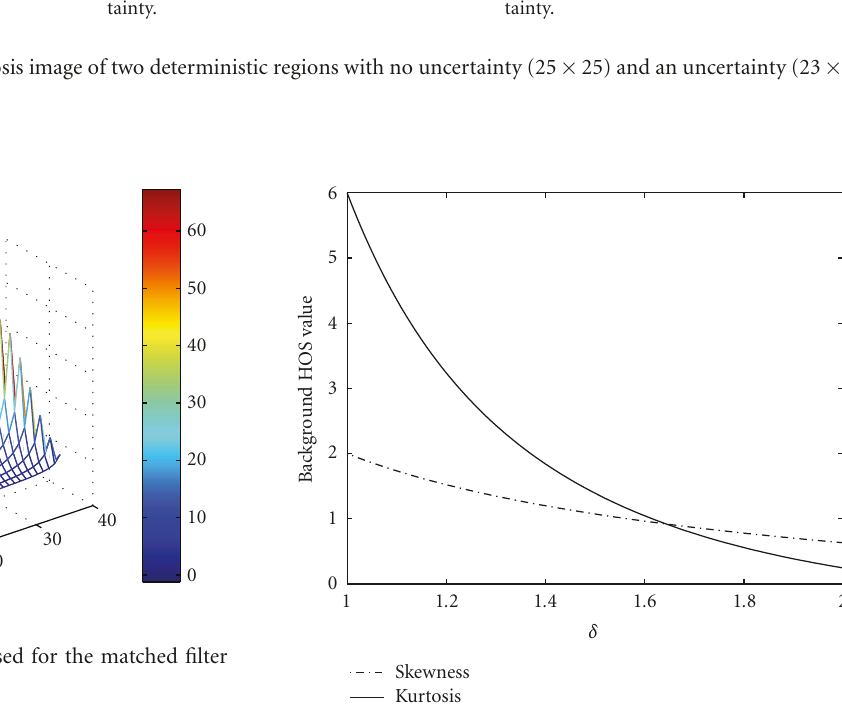
Figure 18: Weibull background HOS values in function of the pa- rameter δ